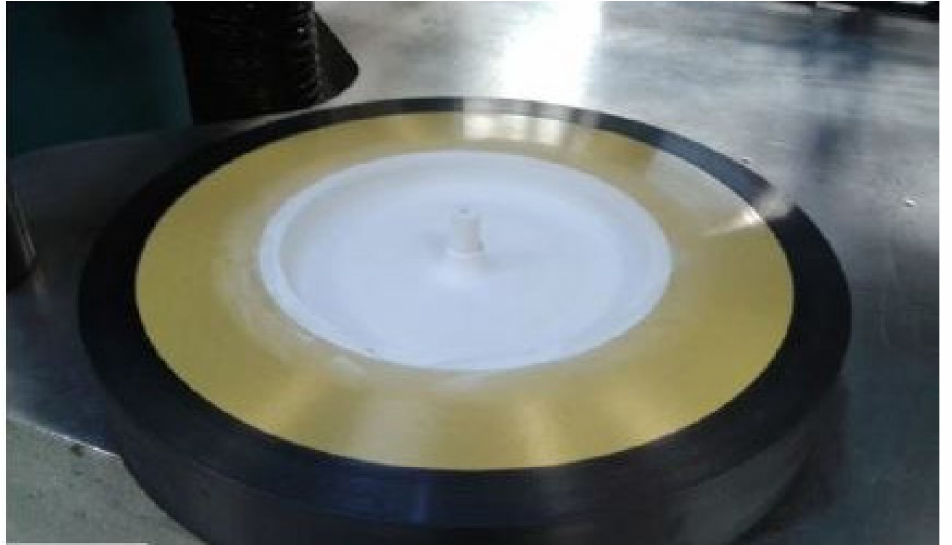
Figure 3. Thermal press-fit accomplished by cooling the aluminum hub with liquid nitrogen before pressing into the composite